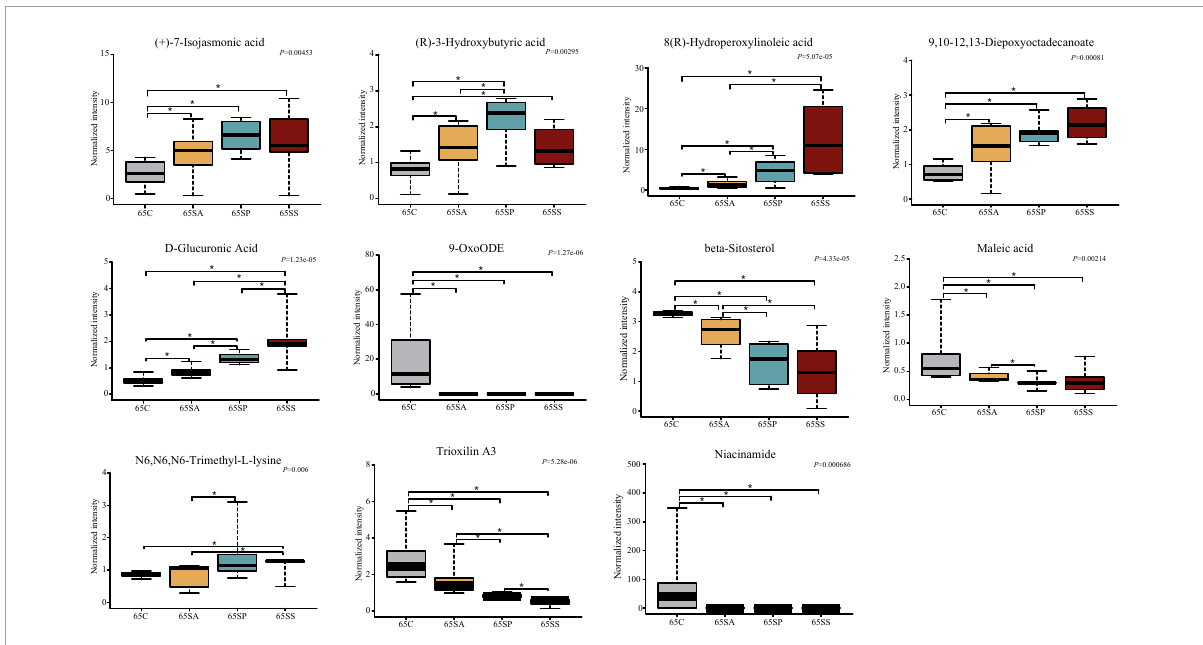
FIGURE7 The box plots of different metabolites at 65 days of age. Asterisk represents P < 0.05. 65C, sow fed with basal diet; 65SA, sow fed with antibiotic; 65SP, sow fed with probiotics; 65SS, sow fed with synbiotics.